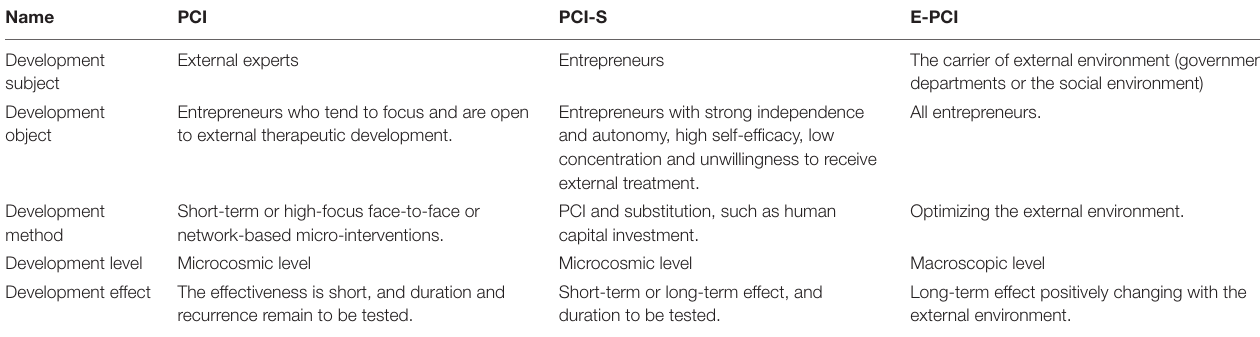
TABLE 2 | Sub-models of the E-PCI-S model.